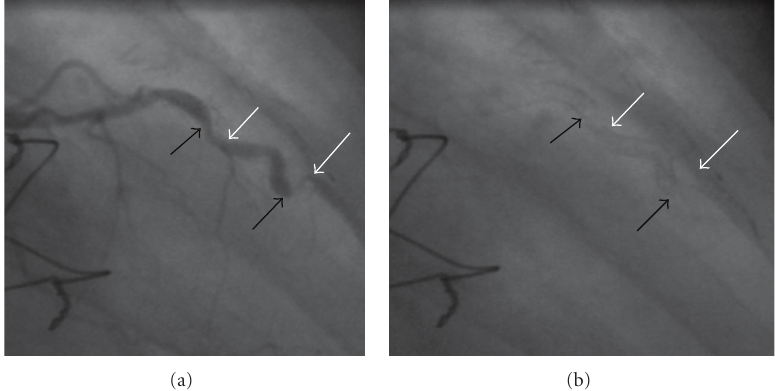
Figure 4: Focal in-stent restenosis of the mid- and distal left anterior descending artery (a). Double stent fracture with complete strut separation in two di ff erent locations